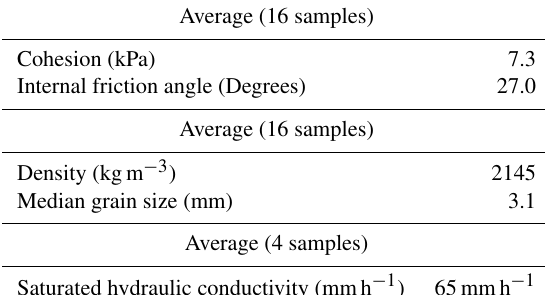
Table 2. Strength parameters for the debris flow material in the Hongchun catchment (Yang, 2010; Hao et al., 2011; Li et al., 2011b) and saturated hydraulic